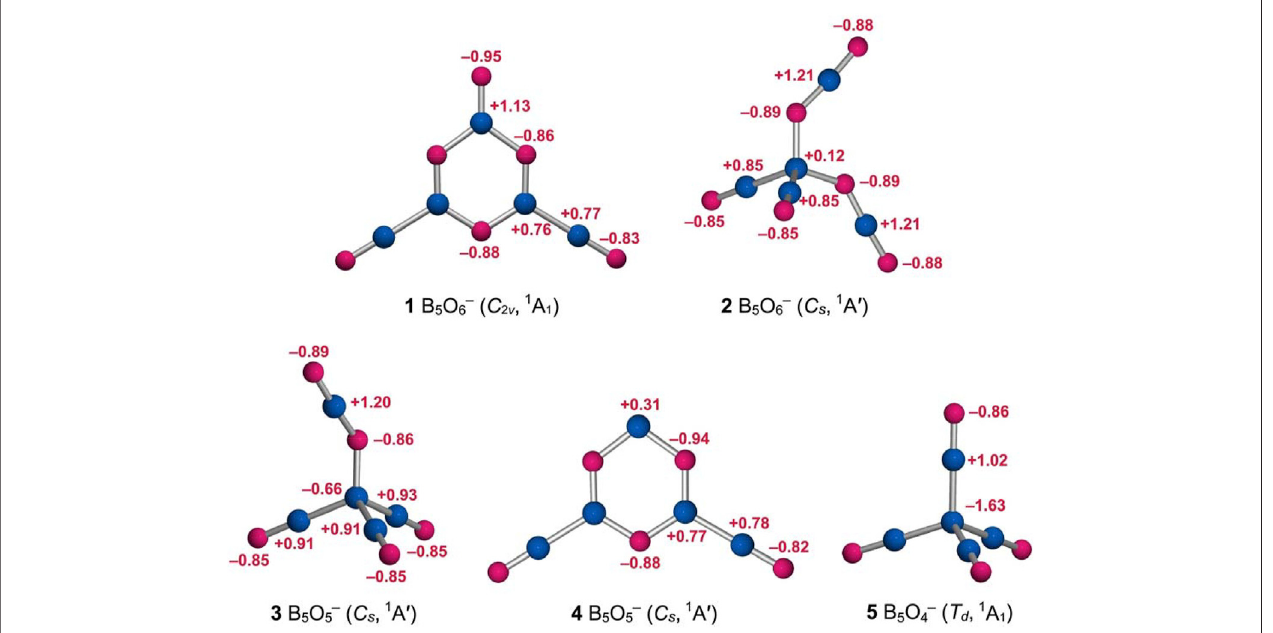
FIGURE4| Calculatednaturalatomiccharges(in|e|)forstructures1and2oftheB 5 O 6 − clusterfromtheNBOanalysisatPBE0/6-311+G(d),ascomparedtothose of B 5 O 5 − (3, C s , 1 A ′ ), B 5 O 5 − (4, C s , 1 A ′ ), and B 5 O 4 − (5, T d , 1 A 1 ) clusters. The B atoms are shown in blue and O in red.